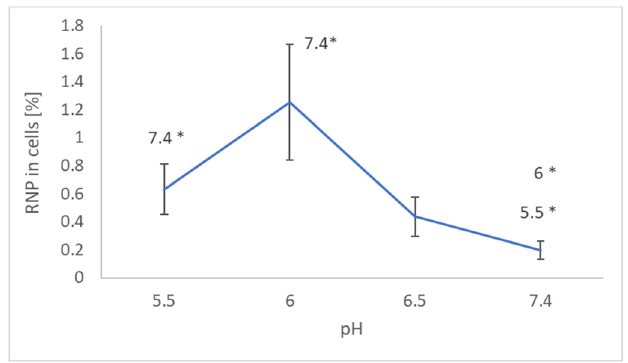
Figure 1. Effect of pH on the uptake of NRNPs pH by SH-SY5Y cells. * p < 0.05 with respect to the pH indicated, Student t -test; n = 3.